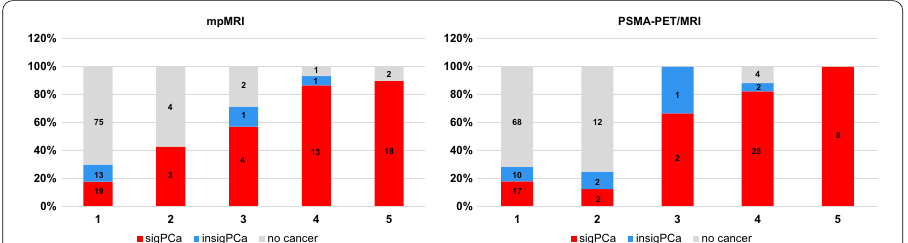
Fig. 3 Imaging findings in relation to biopsy results. Quadrant-based (n to PIRADS on mpMRI and to an adaptation of the same scale for focal uptake on PSMA PET/MRI (1 focal uptake; 2 benign; 3 undetermined; 4 suspicious for malignancy = = = malignancy > 1.5 cm). csPCa clinically significant cancer (red, GS = cancer (blue, GS